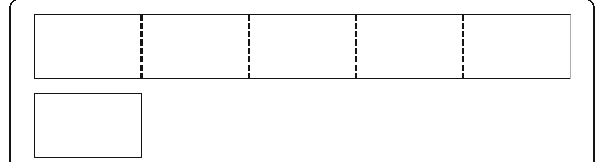
Fig. 3 Determining the unit fractional size of a part relative to the whole